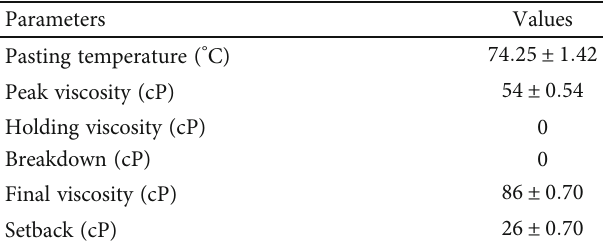
Table 6: Pasting properties of optimized fl our.